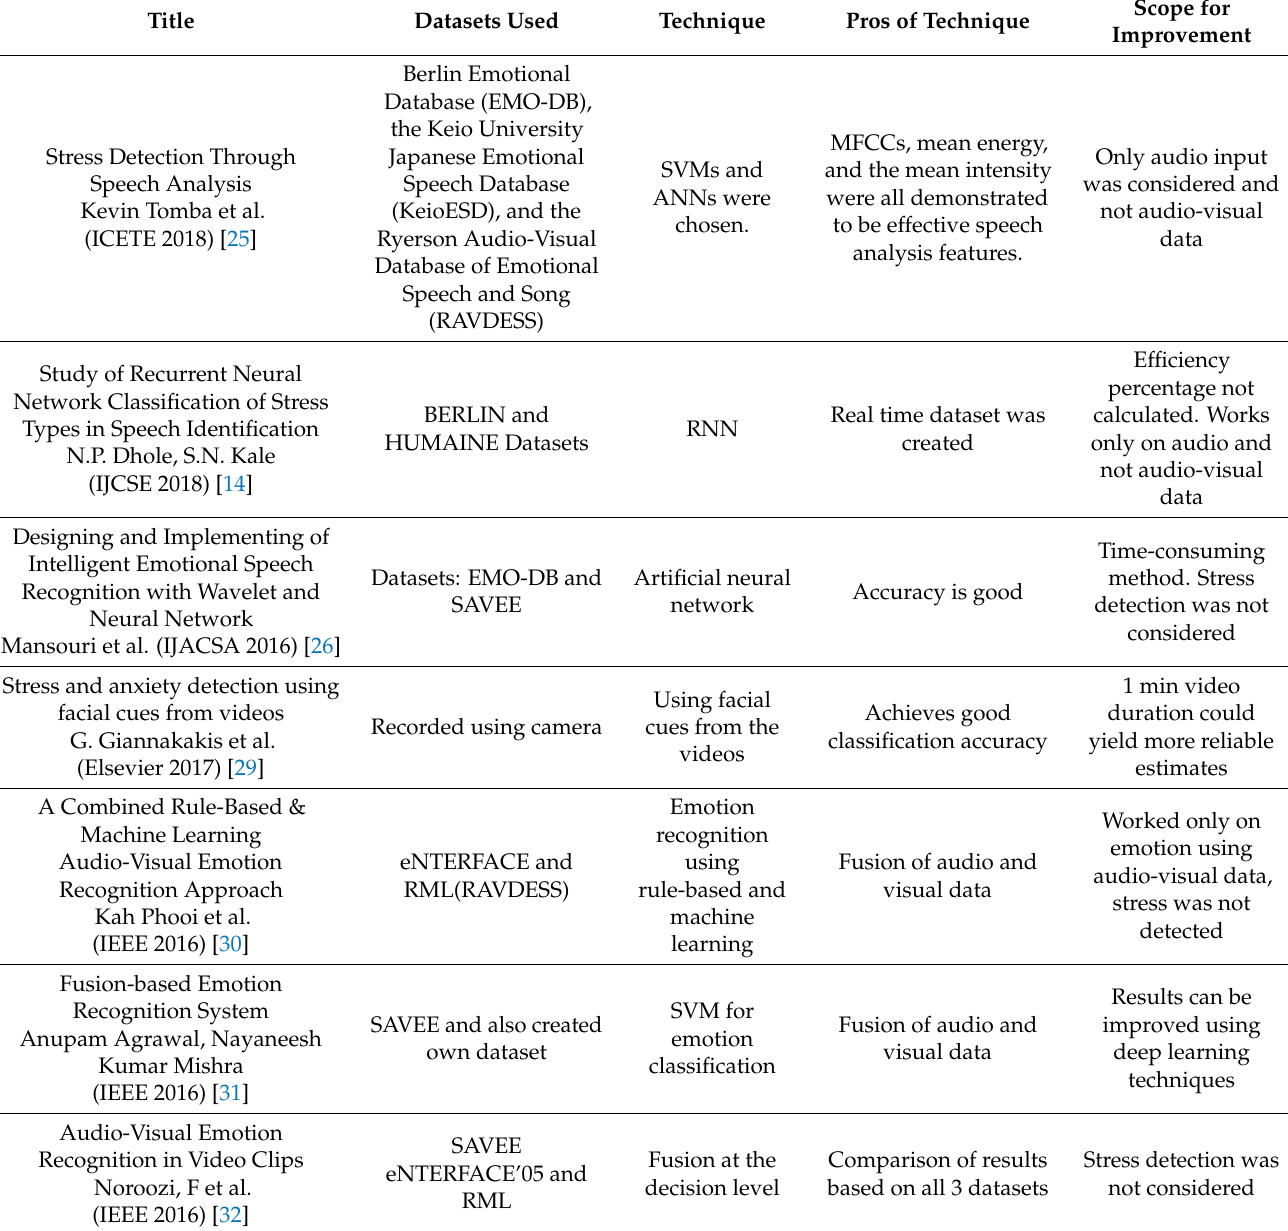
Table 2. Analysis of earlier work in the same field of